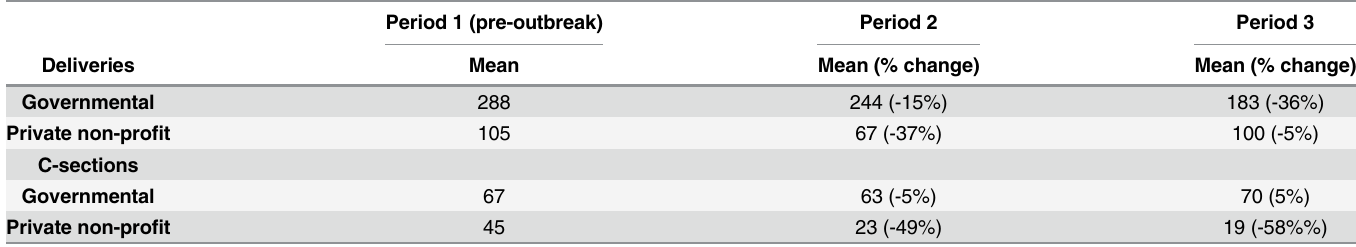
Table 3. In-hospital deliveries and C-sections in Sierra